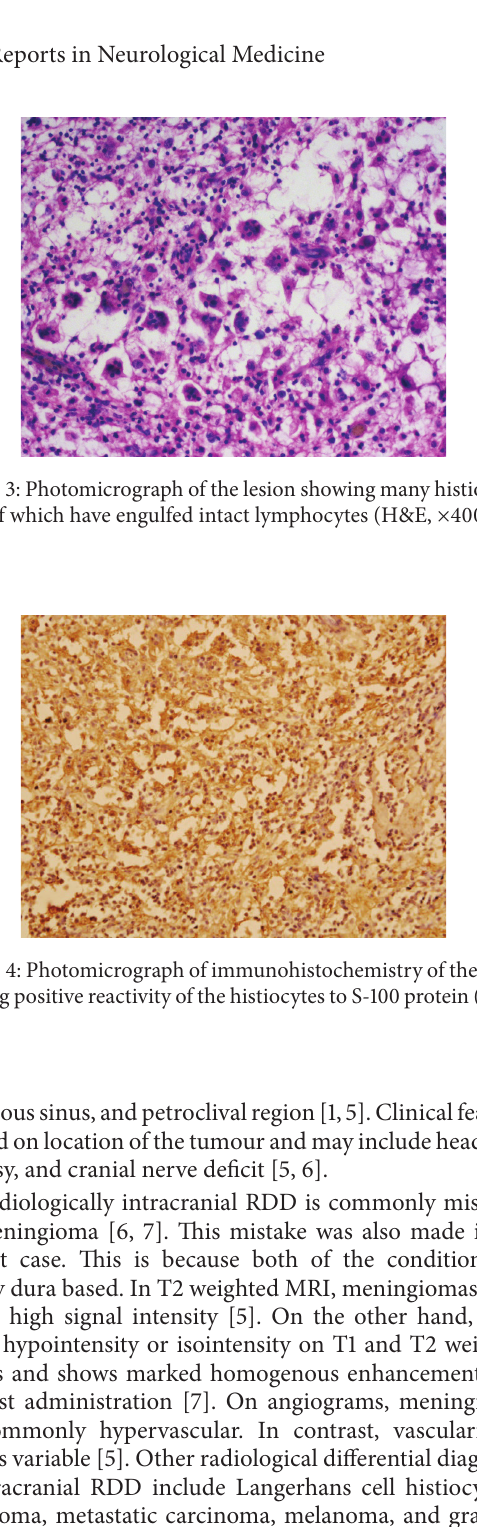
cavernous sinus, and petroclival region [1, 5]. Clinical features depend on location of the tumour and may include headache, epilepsy, and cranial nerve deficit [5,